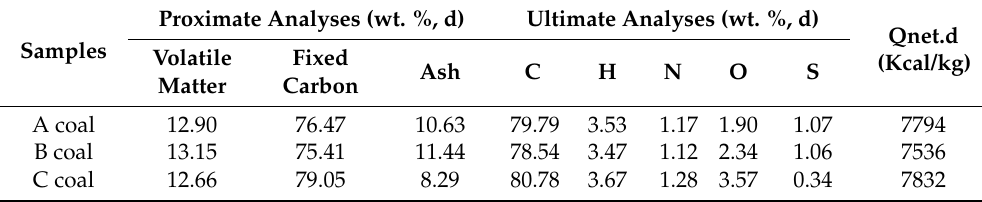
Table 1. Proximate analysis, ultimate analysis, and heating values of coal